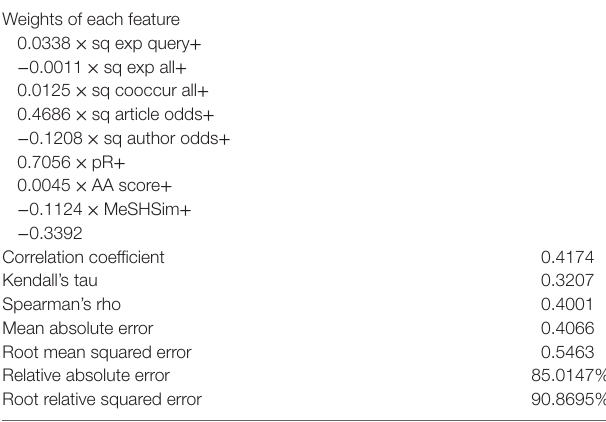
TaBle 6 | Multiple linear regression to predict the number of gap-filling articles appearing in the second time slice in the 10 disease queries only. Weights of each feature 0.0301 × sqrt exp query +